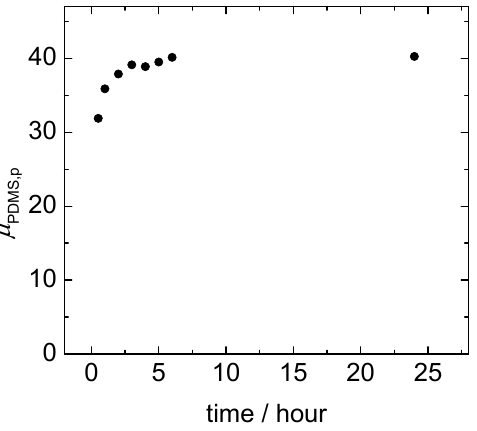
for Series 3 and 5. 0